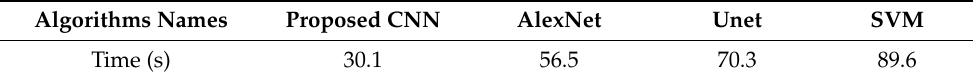
Table 2. Training time.